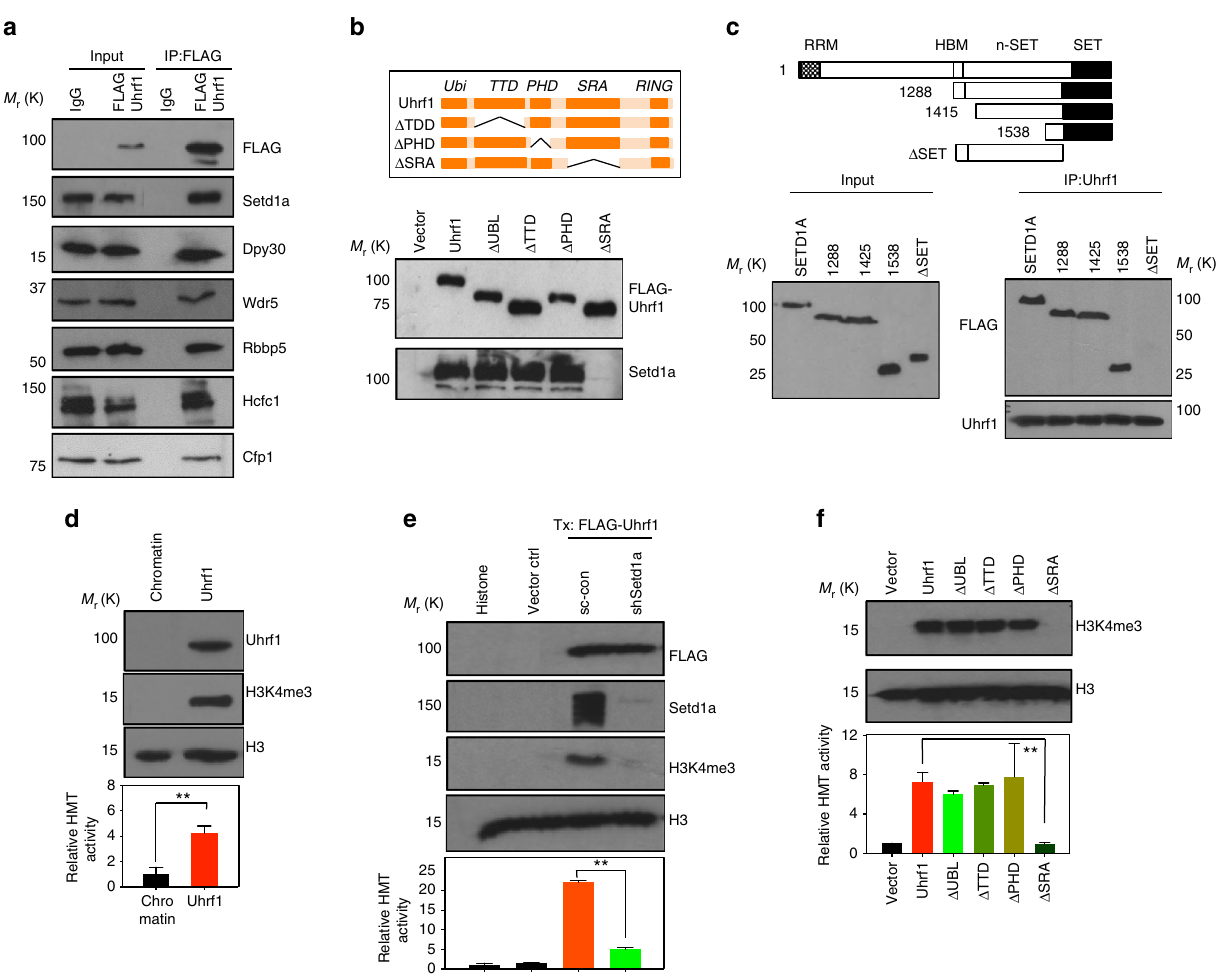
Fig. 3 H3K4 methylation by Uhrf1 complex is mediated via a Setd1a. a Immunoprecipitation analysis of FLAG-tagged Uhrf1 protein. Uhrf1 was co- immunoprecipitated with Setd1a/COMPASS complex proteins isolated from mESCs. The data in c – g are represented as n = 3 experimental replicates (independent HMT assay from different cell cultures). Values are mean ± S.D. ∗∗ P < 0.01, by unpaired, two-tailed Student ’ s t -test analysis. b Mutants of Uhrf1 deleted of speci fi c domain ( Δ Ubi, Ubiquitin domain; Δ TTD, TTD domain; Δ PHD, PHD domain; Δ SRA, SRA domain) were used for co- immunoprecipitation with Setd1a. c SET domain of SETD1A is necessary for interacting with Uhrf1. Series of SETD1A constructs with given deletions were used for Co-IP with Uhrf1. d Uhrf1 complex isolated form mESCs was used for assaying the histone H3K4me3 methyltransferase activity with chromatin as substrate. e Setd1a is a histone methyltransferase in complex with Uhrf1. Depletion of Setd1a reduced the H3K4 methyltransferase activity in